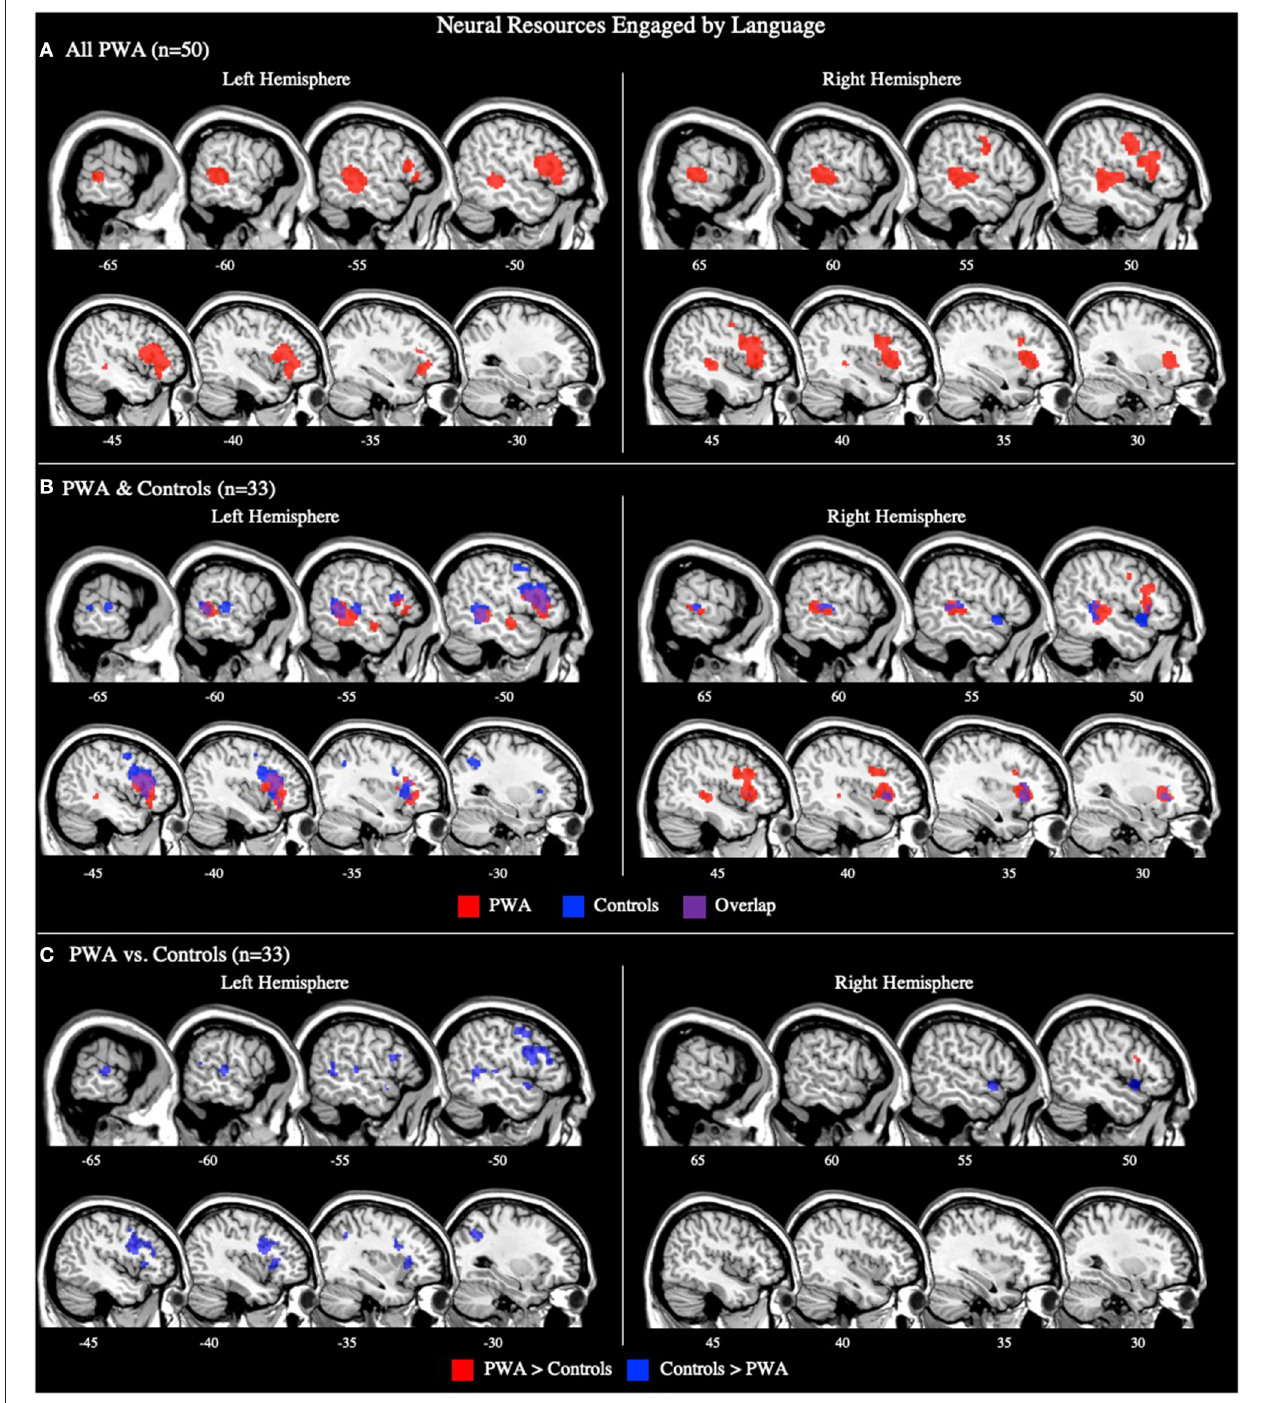
FIGURE 2 | Representative sagittal slices for the combined production and comprehension ALEs in (A) PWA ( p < 0.001 corrected), (B) PWA and controls ( p < 0.001 corrected), and (C) PWA vs. controls ( p = 0.05 uncorrected). (B,C) only include data from tasks which included both PWA and control data. Sample size denotes the number of tasks included in the